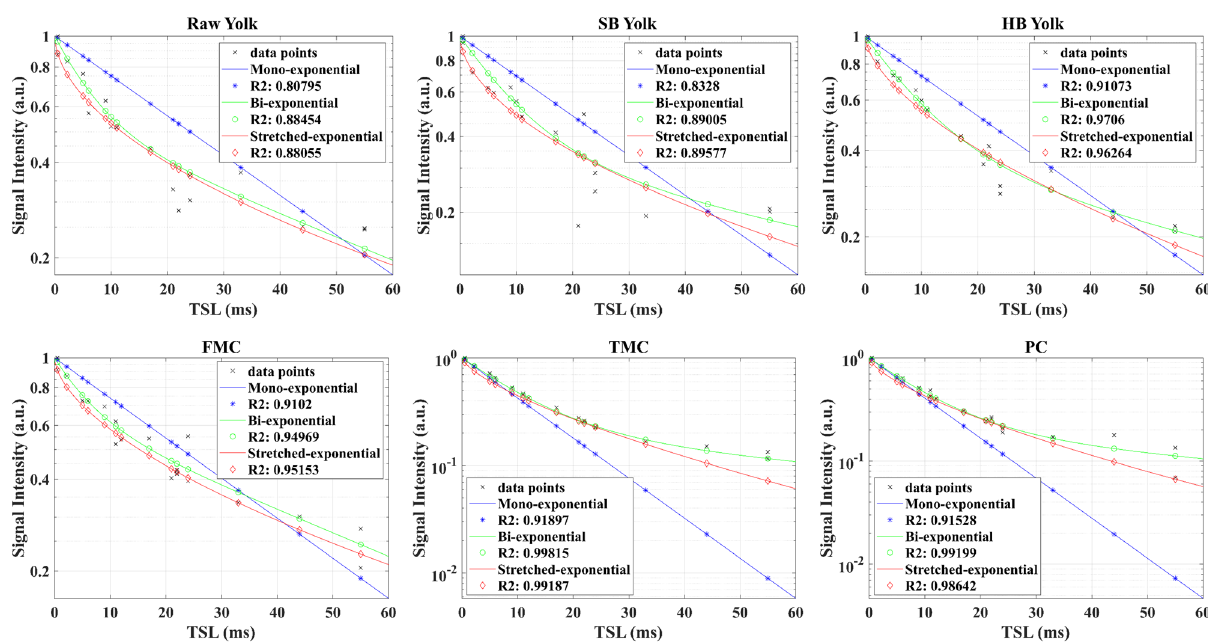
Figure 7. Fitting on representative pixels of raw, soft-boiled (SB), and hard-boiled (HB) yolks, and, of three compartments of knee cartilage: Femorl Medial Cartilage (FMC), Tibial Medial Cartilage (TMC), and Patellar Cartilage (PC). The y-axis is the normalized signal amplitude in the